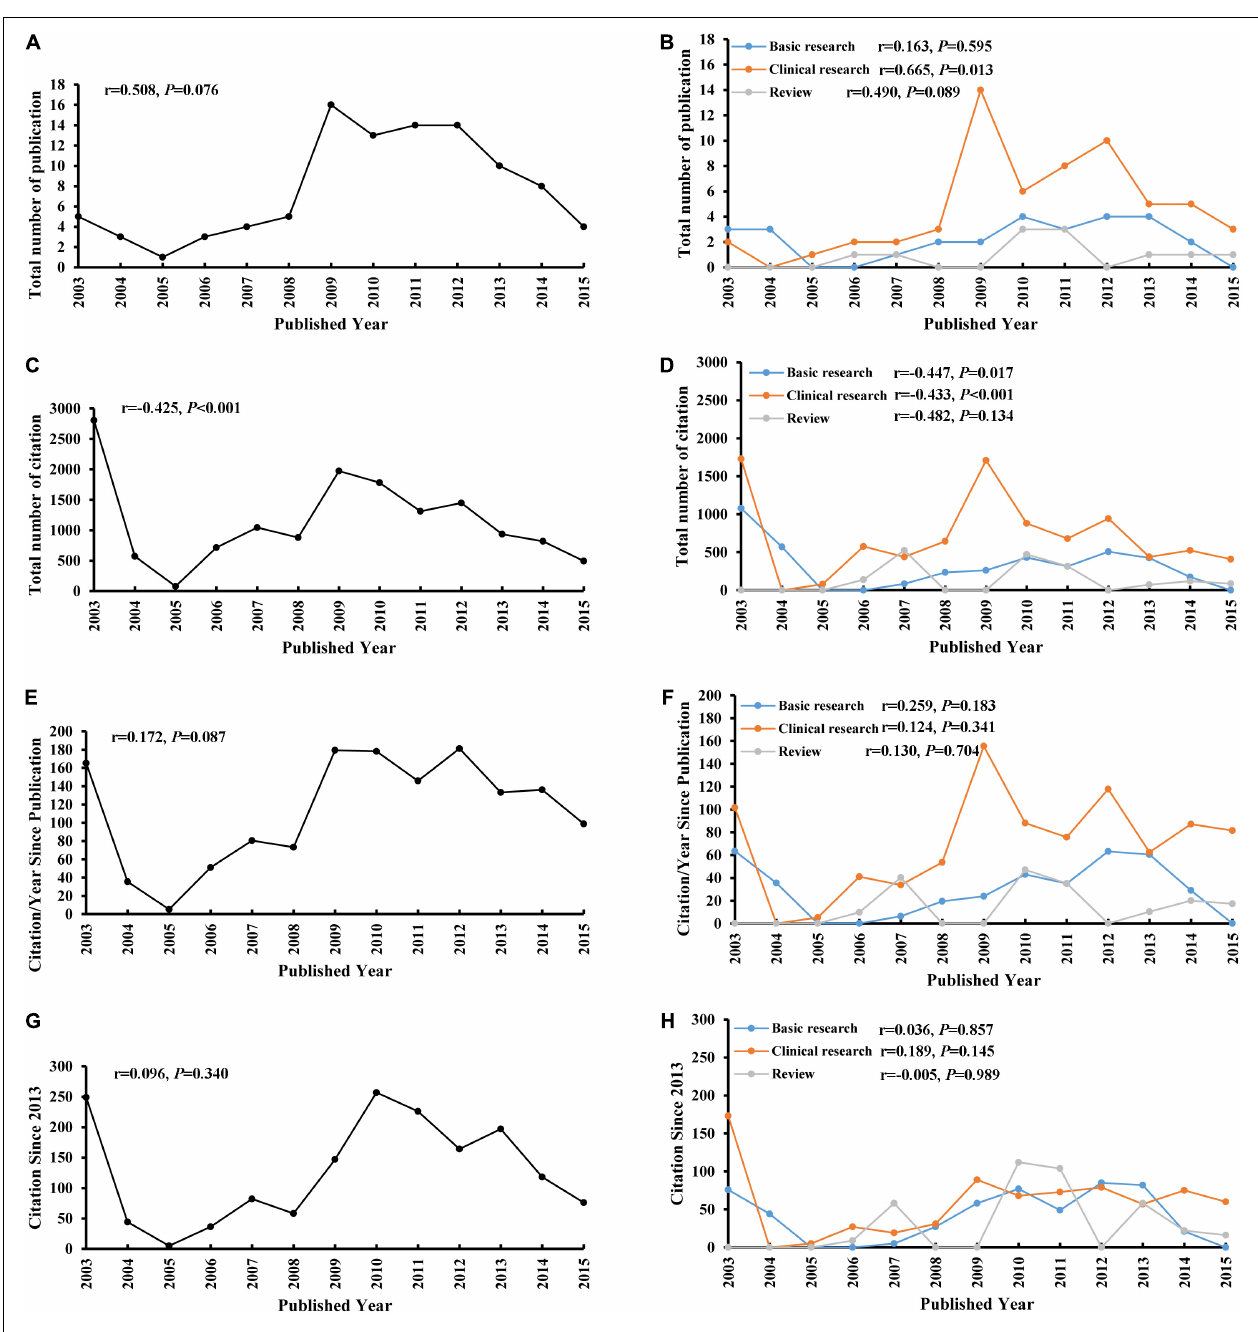
FIGURE 1 | Publication and citation according to published year. (A) total number of publication; (B) total number of publication per type of article; (C) total number of citation; (D) total number of citation per type of article; (E) citation/year since publication; (F) citation/year since publication per type of article; (G) citation since 2013; and (H) citation since 2013 per type of